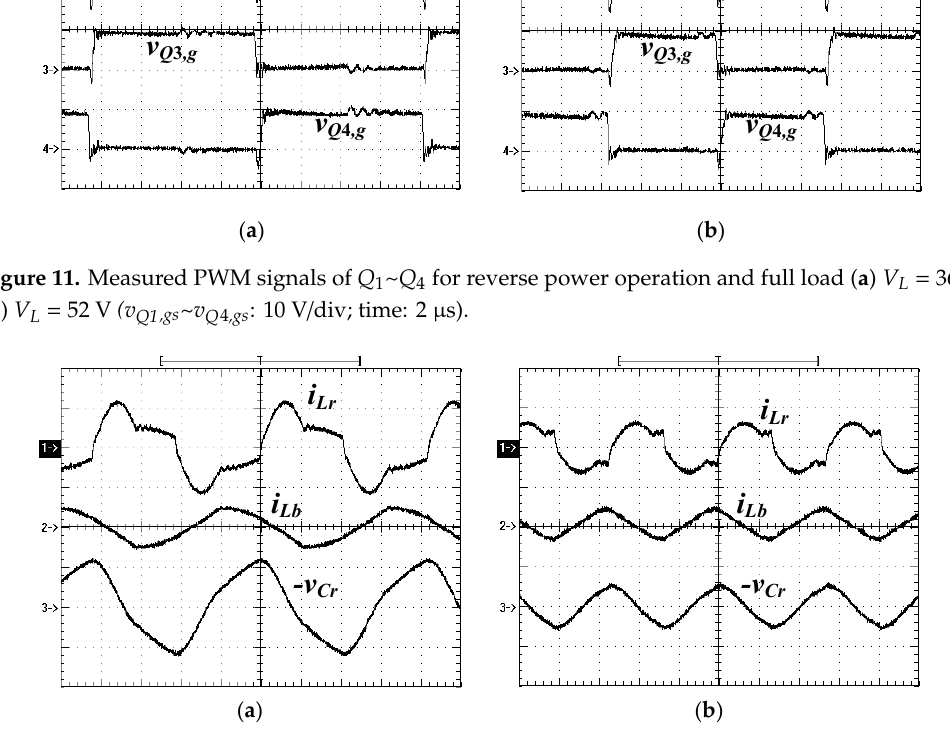
Figure 12. Measured results of i Lr , i Lb and v Cr for reverse power operation and full load ( a ) V L = 36 V ( b ) V L = 52 V ( i Lr , i Lb : 10 A/div; v Cr : 500 V/div; time: 4 μ s).